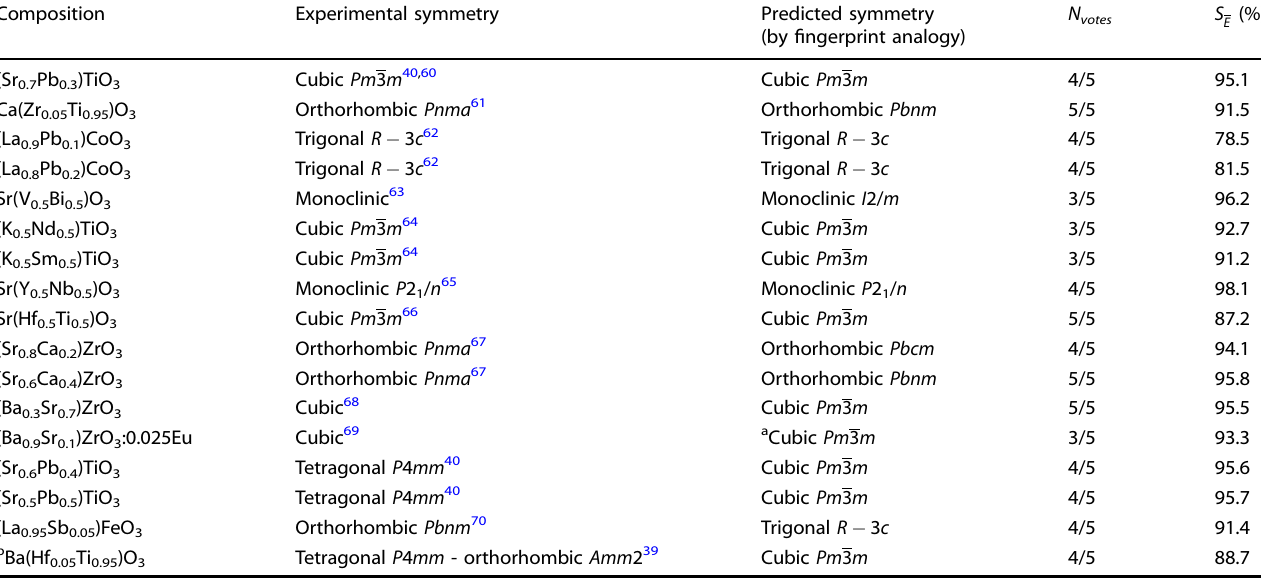
Table 3. Crystal system prediction of perovskites not present in the ICSD using material fi ngerprints.